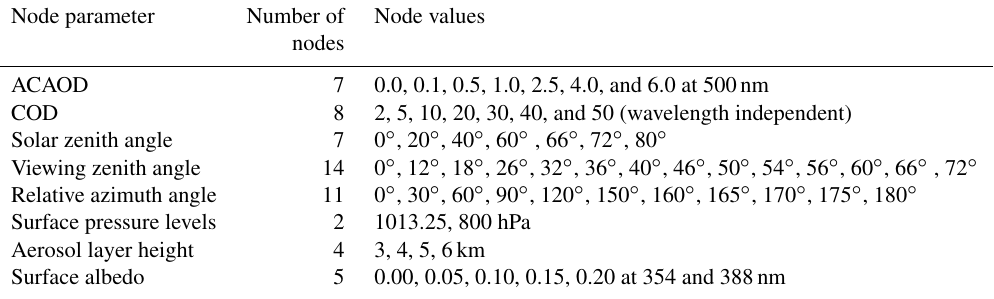
Table A4. Nodes of OMACA look-up table. Node